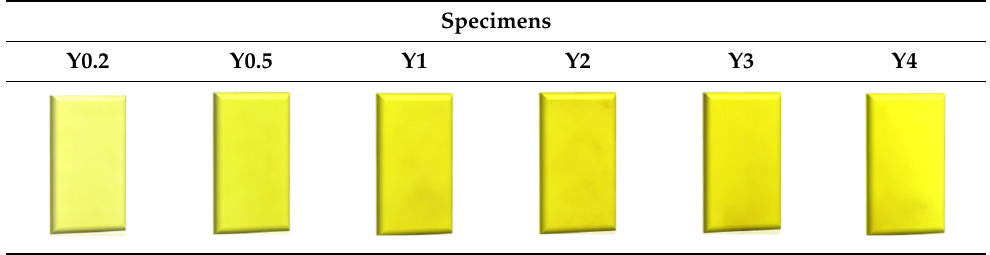
Figure 4. Spectral curves of yellow hue specimens (legend according to Tables 4 and 5). Table 4. Specimens dyed with Disperse yellow 3 (DY3).